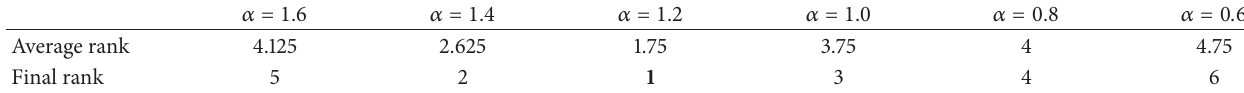
Table 4: Rank results of different setting of 𝛼 in